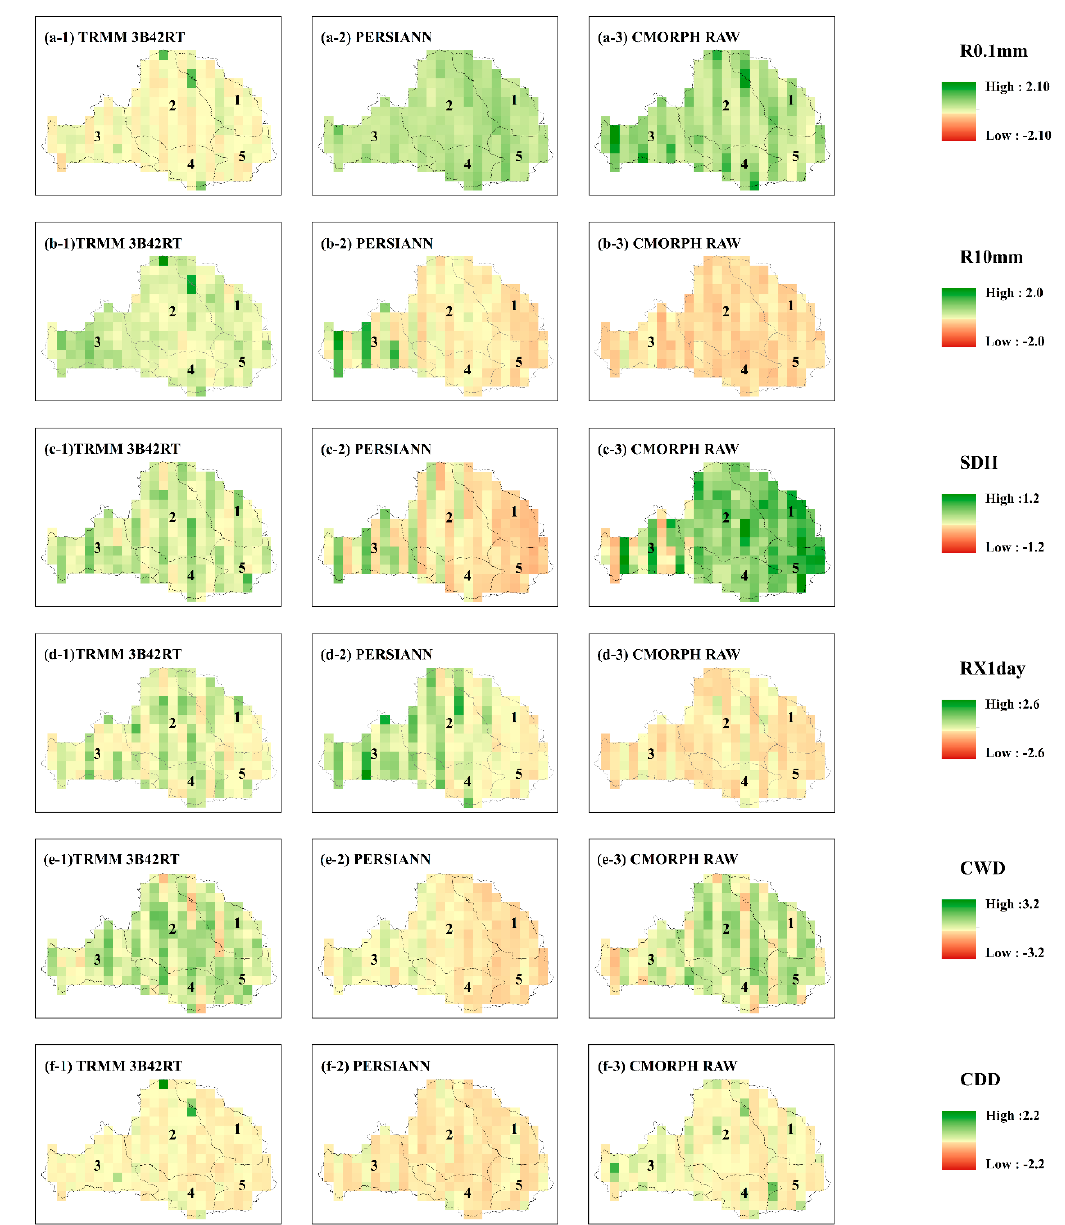
Figure A3. Spatial distribution of mean relative error of six extreme precipitation indices for the three near real-time products.